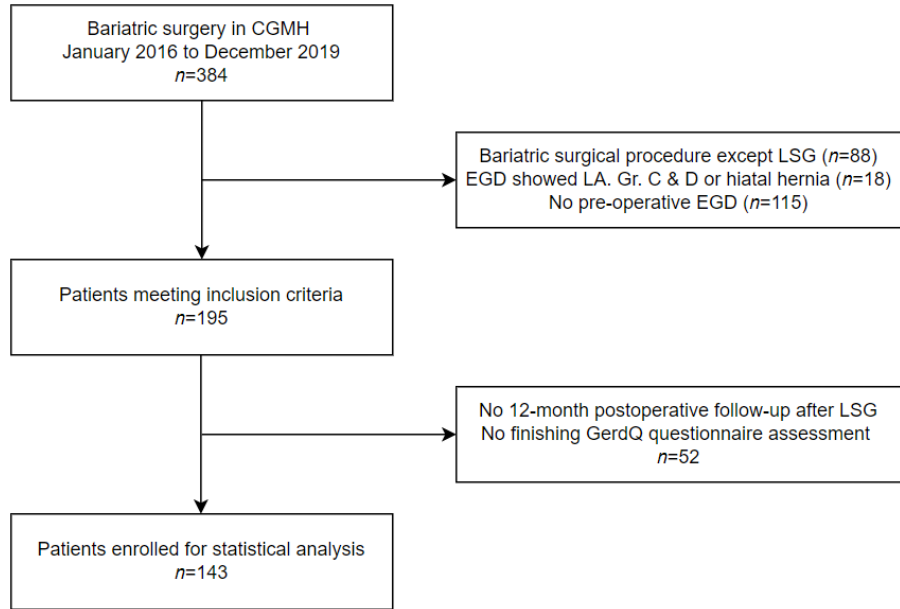
Figure 1. Study flow chart. CGMH, Chang Gung Memorial Hospital; LSG, laparoscopic sleeve gastrectomy; EGD, esophagogastroduodenoscopy; LA Gr., Los Angeles grade.